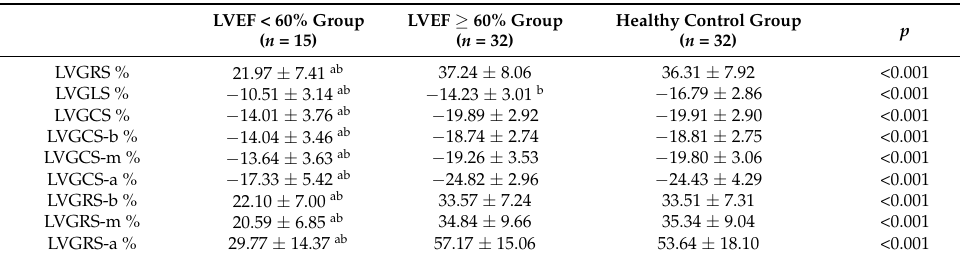
Table 5. Comparison of LV strain parameters among PAH patients with reduced and preserved LV function and healthy